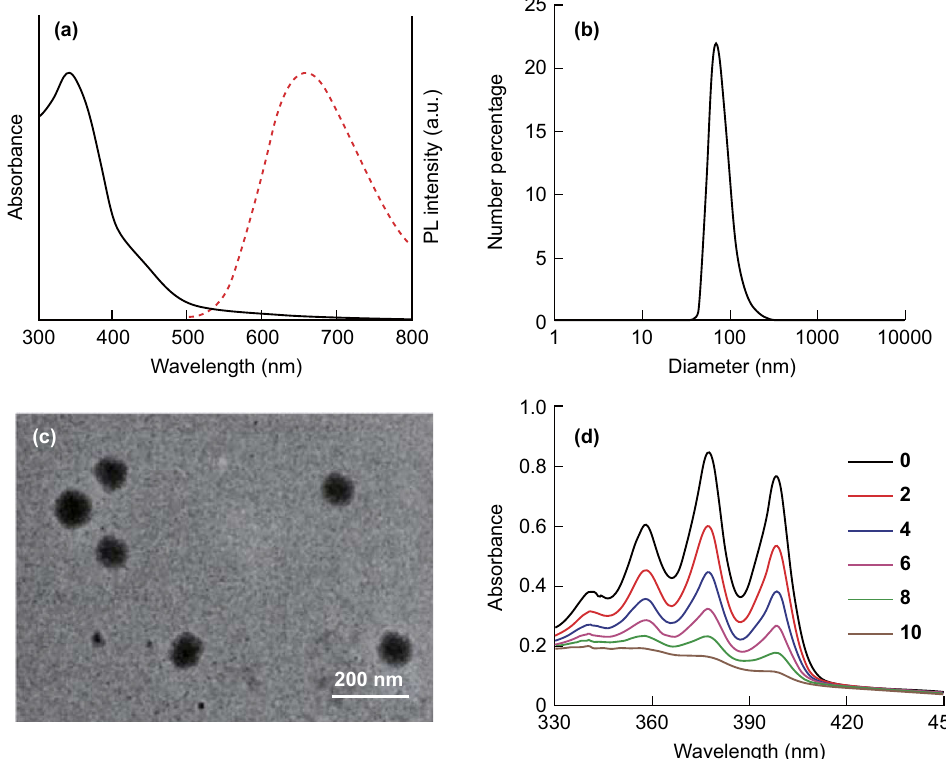
Fig. 1 a UV–visible absorption (solid line) and photoluminescence (PL, dashed line) spectra of PPDCT-DSPE-mPEG NPs. b Number size distribution of PPDCT-DSPE-mPEG NPs. c TEM image of PPDCT-DSPE-mPEG NPs. d Absorbance decay of 64 l M ABDA in the presence of PPDCT NPs over 10 min of 0.15 W cm - 2 white